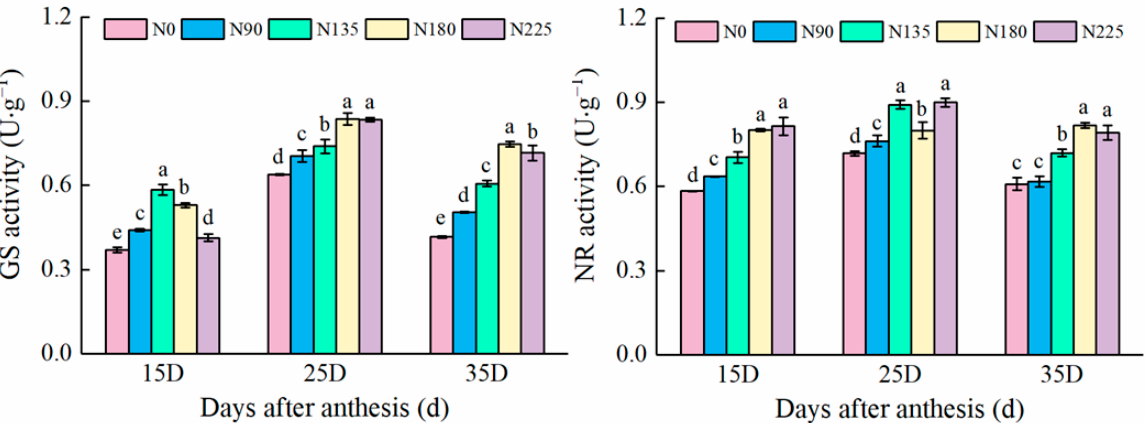
Figure 4. Effects of N application on enzyme activity in rice. Lower case letters indicate that the physical and chemical properties of the low-gluten rice are significantly different with the different treatments ( p < 0.05, LSD method).